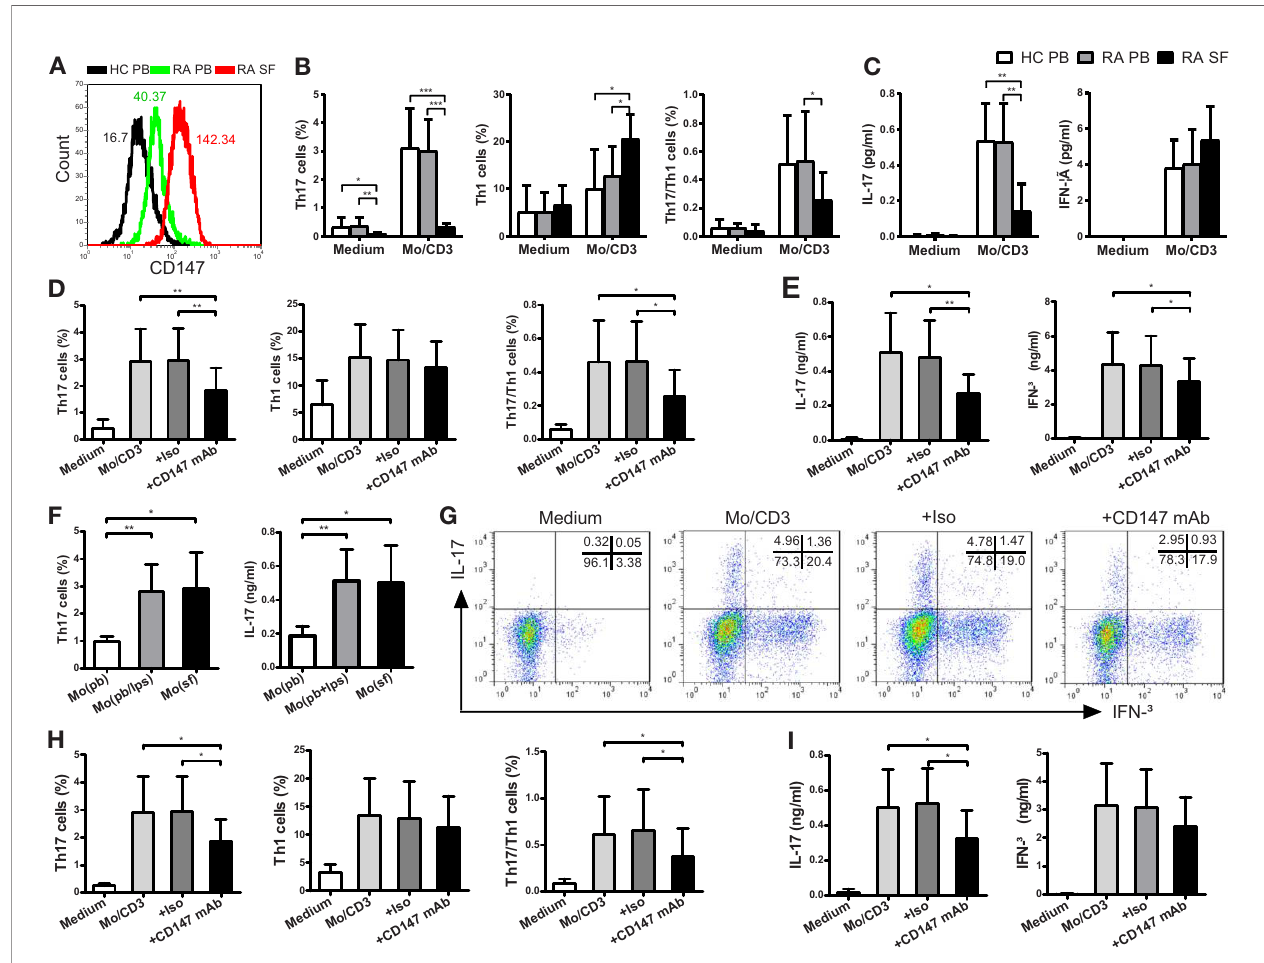
FIGURE 4 | CD147 suppresses Th17 responses in patients with RA. (A) Representative CD147 staining histogram in CD4 + Tm cells from the peripheral blood of HC (HC PB), PB of RA (RA PB) and synovial fl uid of RA (RA SF). (B , C) CD4 + Tm cells from HC PB (n = 13), RA PB (n = 12) or RA SF (n = 6) were isolated and cocultured with medium or autologous PB LPS-activated Mo and anti-CD3 mAb. (D , E) CD4 + Tm cells from RA PB were cocultured with medium or LPS-activated Mo in absence or presence of Iso or anti-CD147 mAb. Percentages of Th17, Th1 and Th17/Th1 cells (B, D) and levels of IL-17 and IFN- g (C, E) are shown. (F) CD4 + Tm cells from RA PB were cocultured with autologous Mo from PB (Mo (pb)), LPS-activated Mo from PB (Mo (pb/lps)) or Mo from SF (Mo (sf)), then Th17 cell percentage and IL-17 level are shown (n = 6). (G – I) CD4 + Tm cells from RA PB were cocultured with medium or Mo from SF in absence or presence of Iso or anti- CD147 mAb. Representative plots (G) and quantitative results of intracellular expression of IL-17 and/or IFN- g (H) in T cells, and IL-17 and IFN- g levels in cell culture supernatants (I) were shown (n = 6). * P < 0.05; ** P < 0.01; *** P <